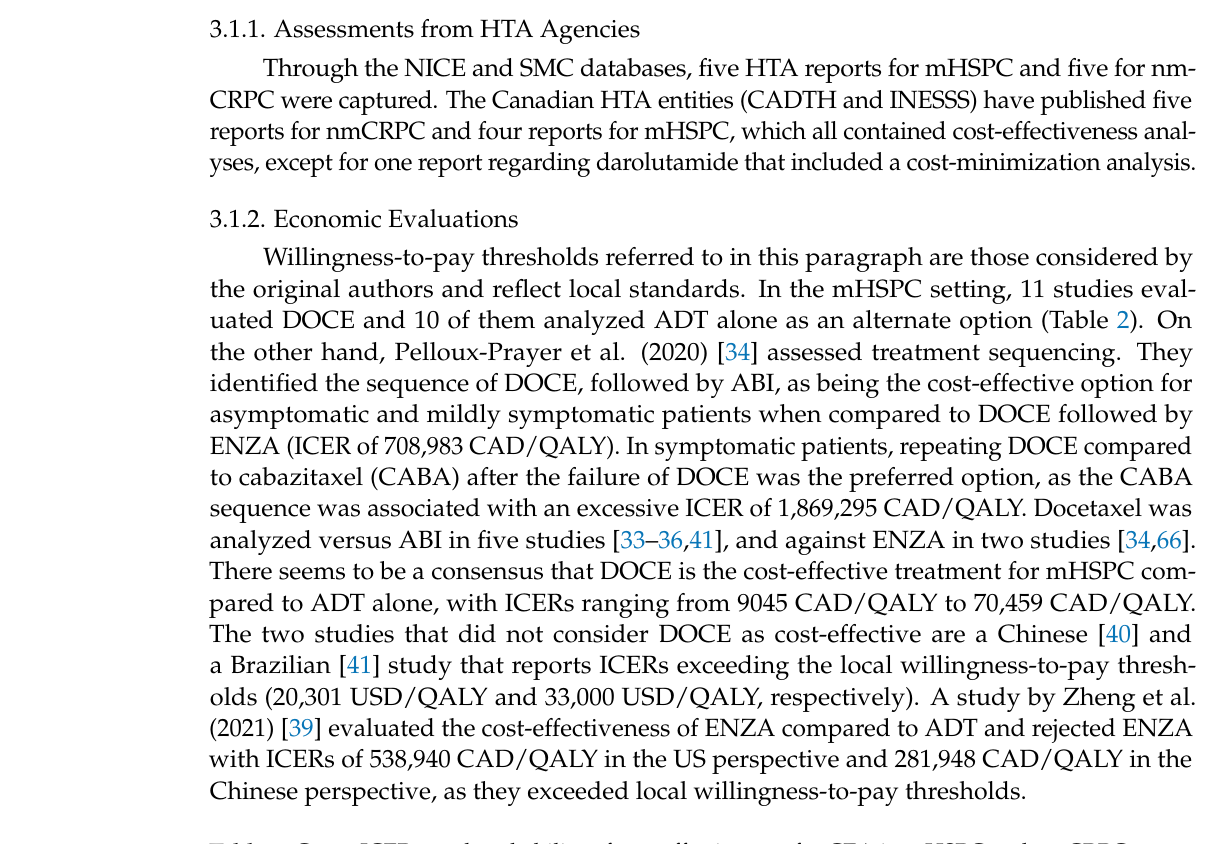
Table 2. Costs, ICERs, and probability of cost effectiveness for CEA in mHSPC and